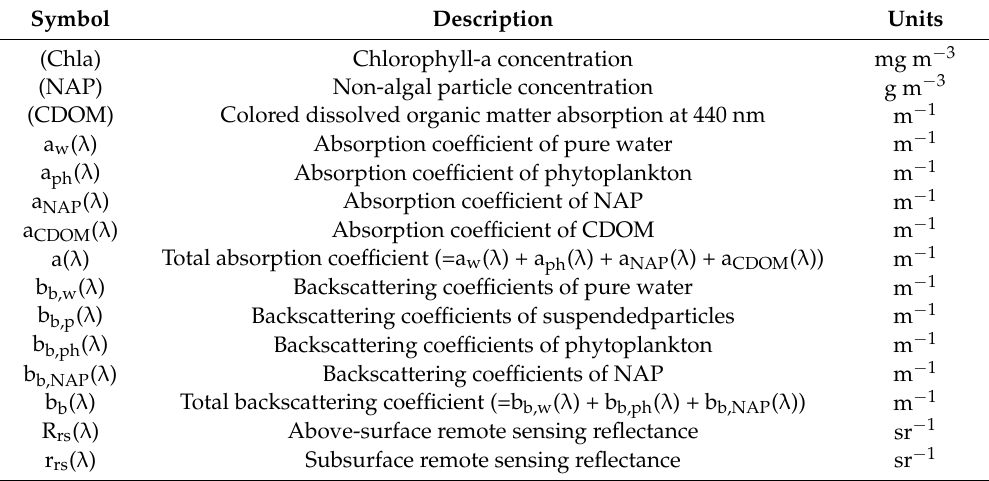
Table 2. Symbols and